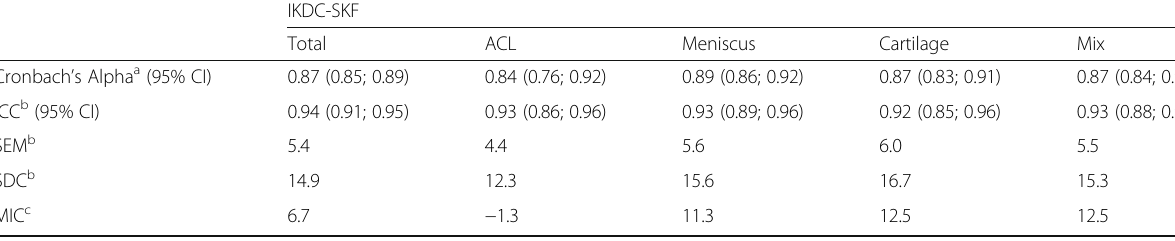
Table 2 IKDC-SKF reliability and minimal important change